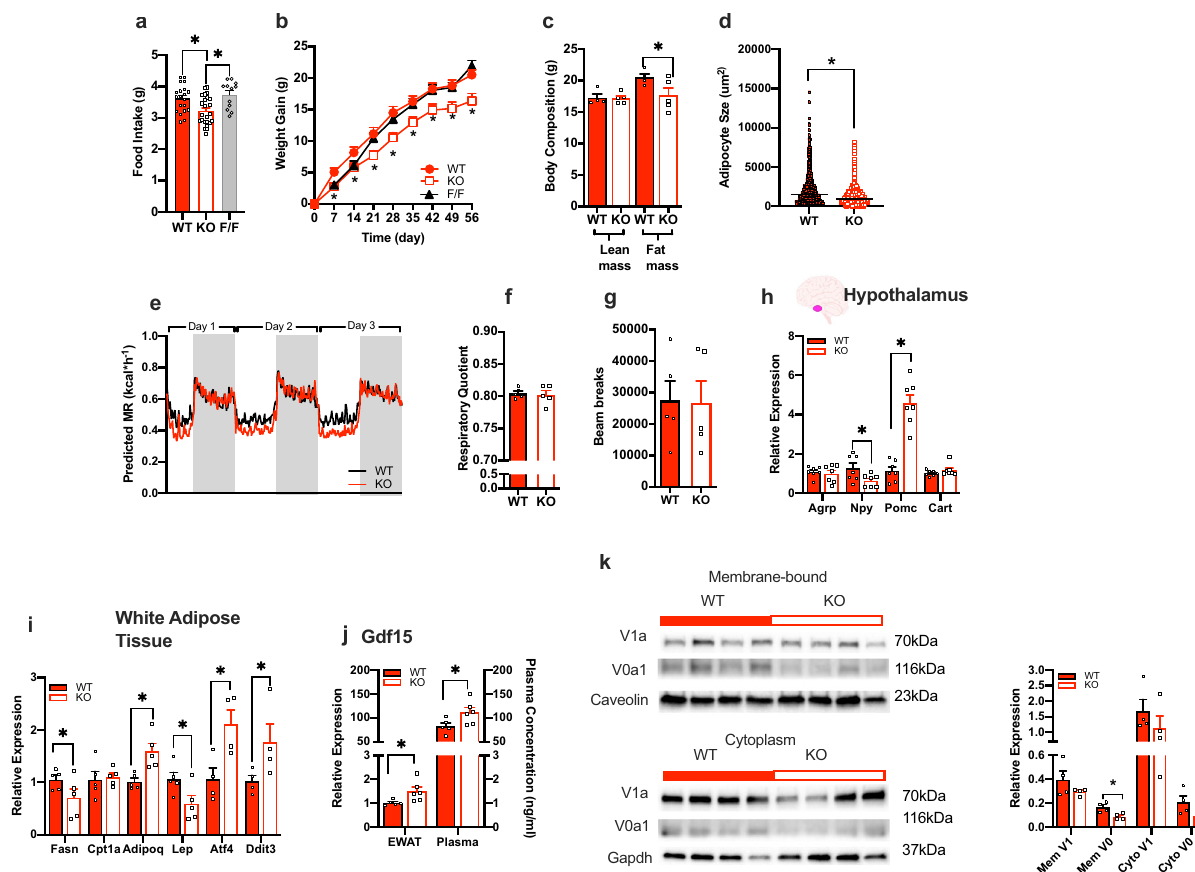
Fig. 4 | Adipocyte-speci fi c Atp6v0a1 KO mice fed HFD gain less weight due to reduced food intake. a Average daily food intake (WT n =20, KO n =24, FF n =12, F =7.03, df=55, p =0.002), b weight gain (WT, n =13, KO n =16, FF n =12, F =5.06, df=266, p =0.01) in WT (red), KO (white) and FF (gray) mice. c Body composition ( n =5/group, lean mass: t =0.11, df=7, CI= − 1.70 – 1.536, p =0.91; fat mass: t =2.07, df=7,CI= − 6.06to0.409, p =0.04), d adipocytesize( t =0.21,df=3665,CI= −